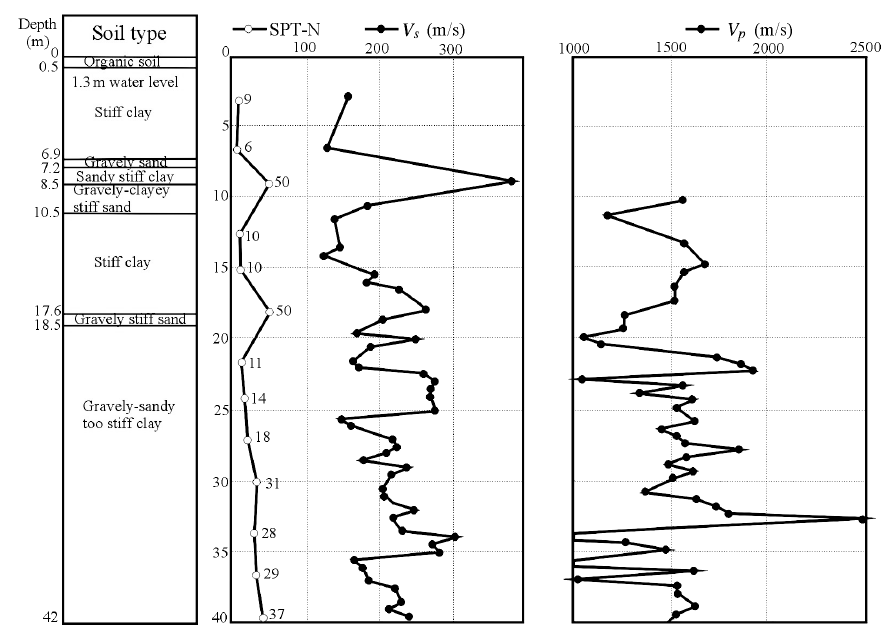
Fig. 5. Depth-section and physical parameters obtained by down-hole test at Sk3 borehole (after Gullu,